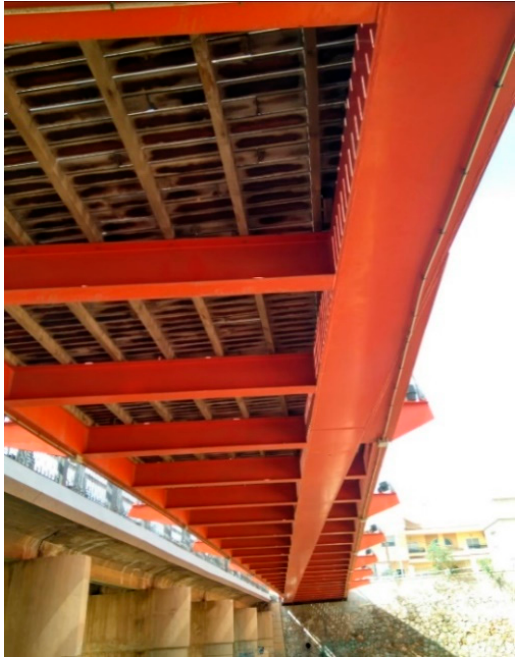
Figure 37. Fish-spine in the deck of the Barrio de la Concepción Bridge (14b), Cartagena (Spain). Photo by the Juan Manuel García-Guerrero.